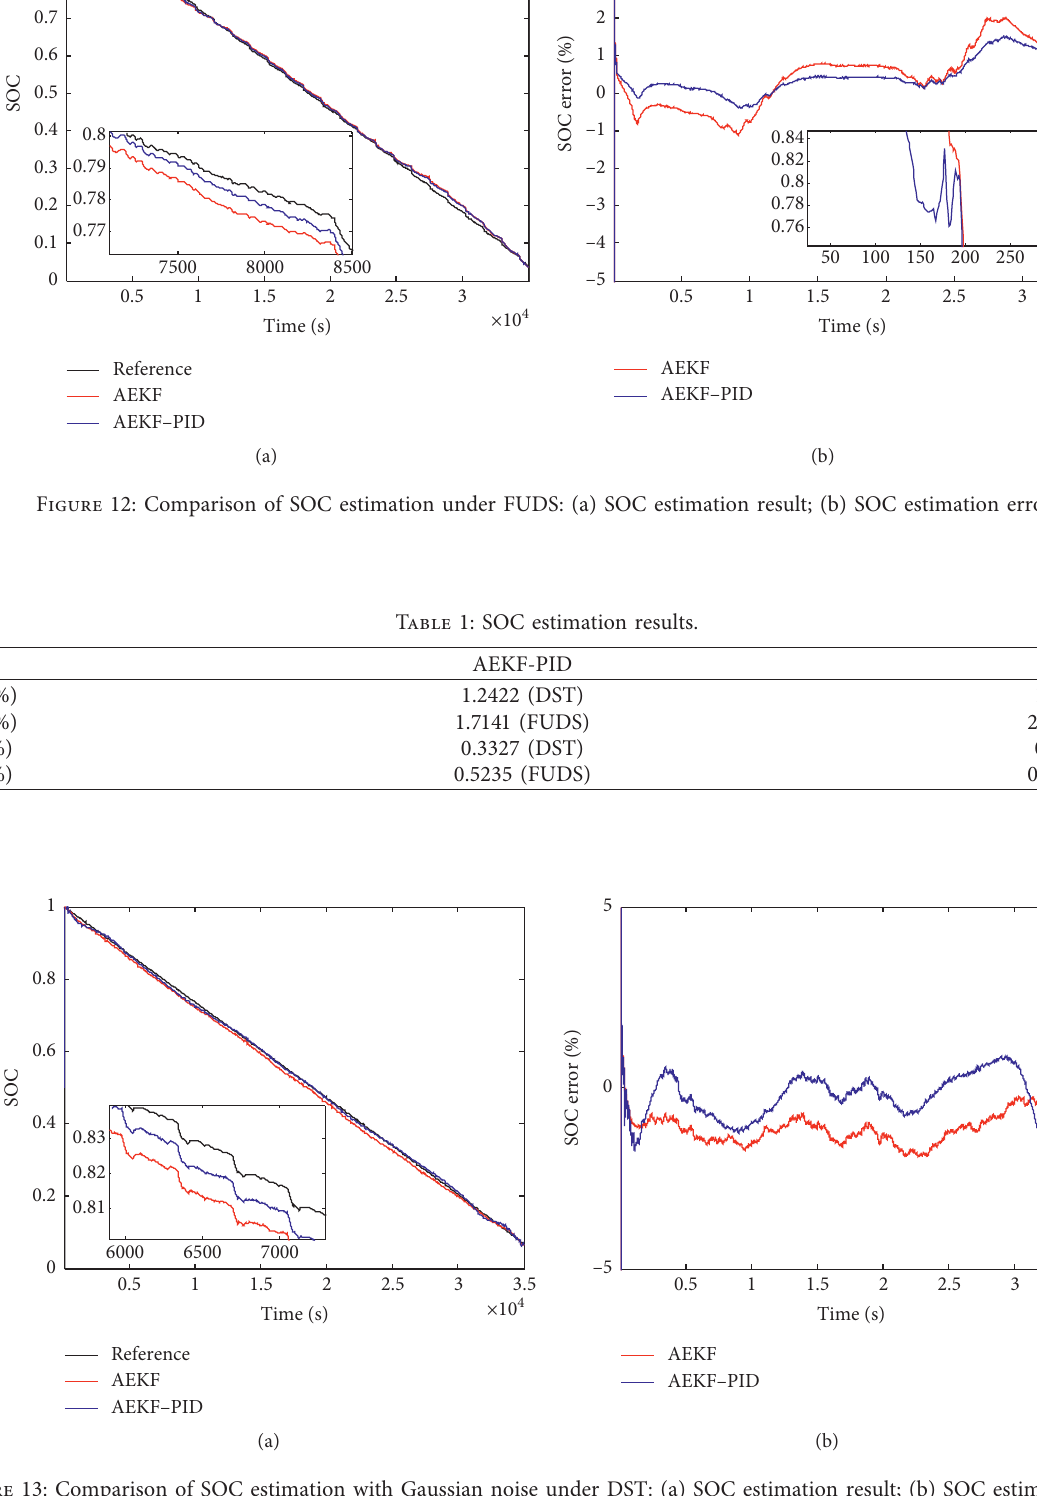
Figure 13: Comparison of SOC estimation with Gaussian noise under DST: (a) SOC estimation result; (b) SOC estimation error.